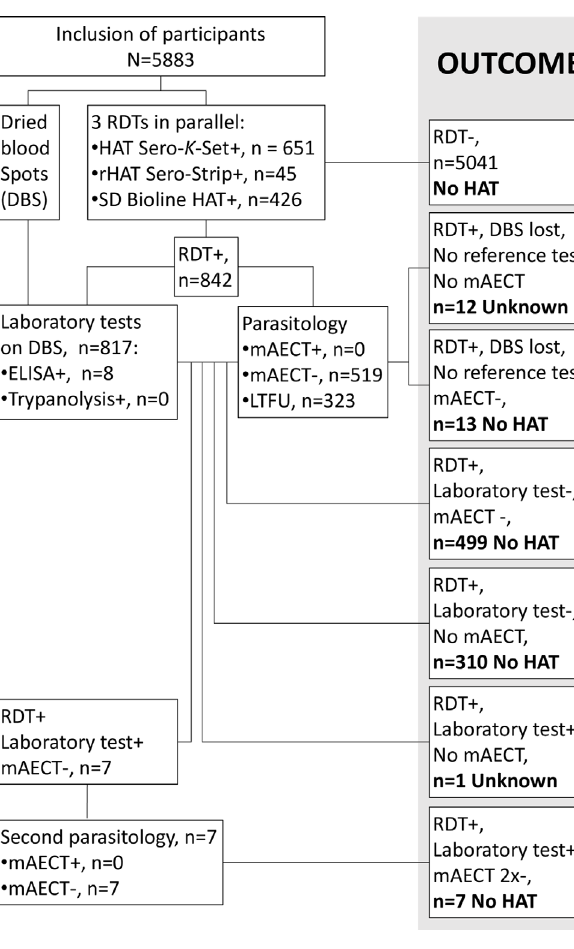
Figure 3. Flow chart of activities, test results and diagnostic outcome of participants. RDT = Rapid Diagnostic Test; DBS = dried blood spot; mAECT = mini anion-exchange/centrifugation tech- nique; LTFU = lost to